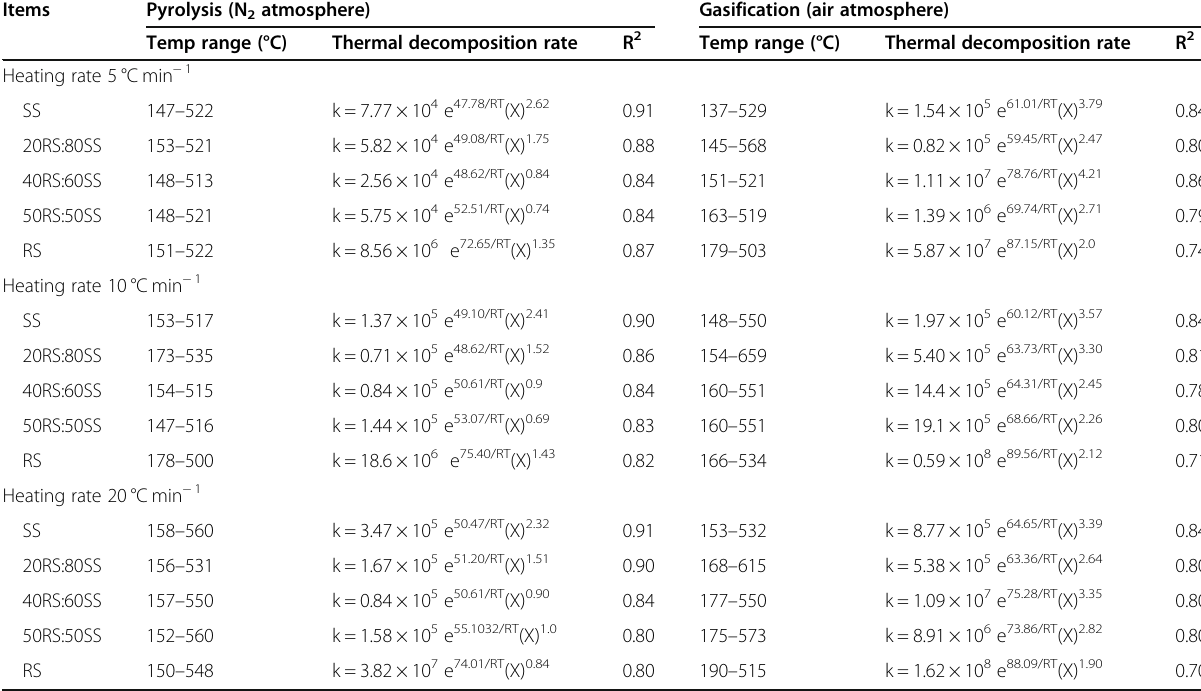
Table 3 Kinetic constants for pyrolysis and gasification at different heating rates